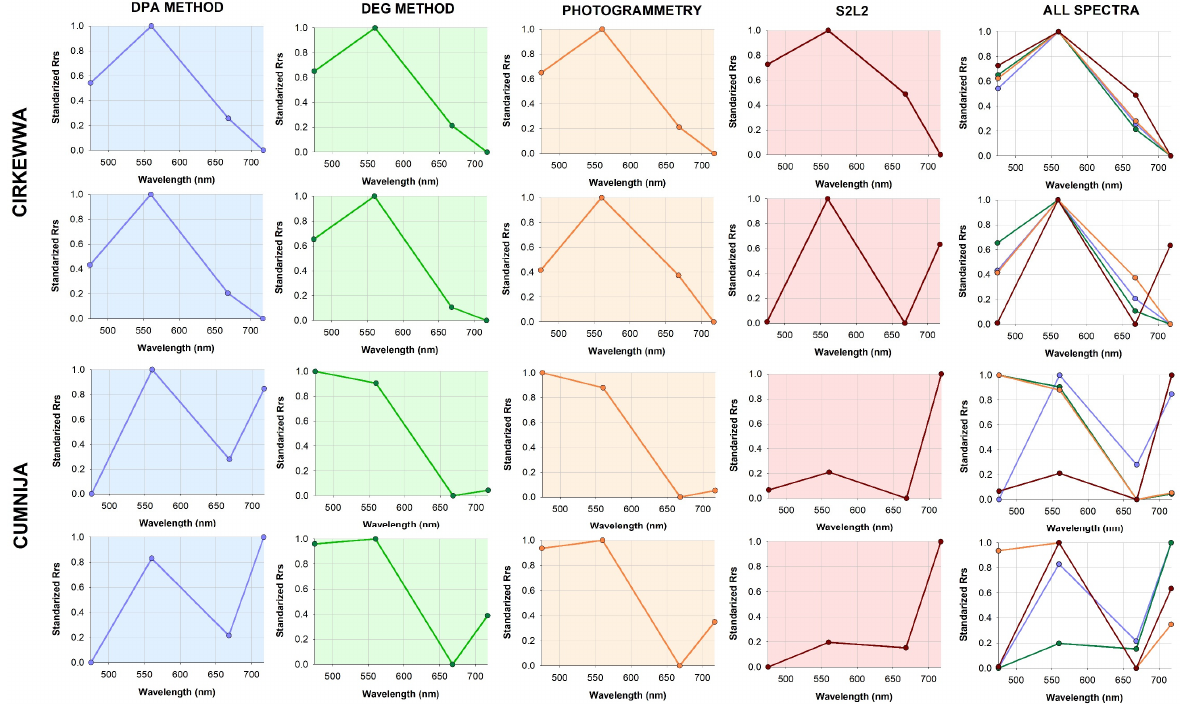
Figure 6. Water-reflectance spectra retrieved from the DPA method, the DEG method, SfM photo- grammetry, and S2 imagery at two different points in each study location. togrammetry, and S2 imagery at two different points in each study